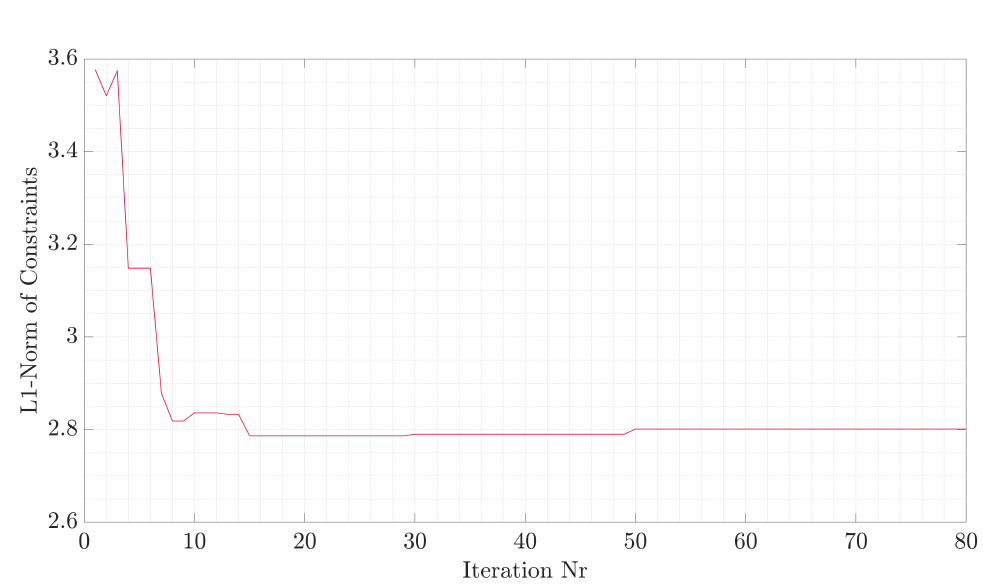
Figure 13. Convergence of the L1-norm of the constraints violation. Table 11. SBO results in terms of objective function and